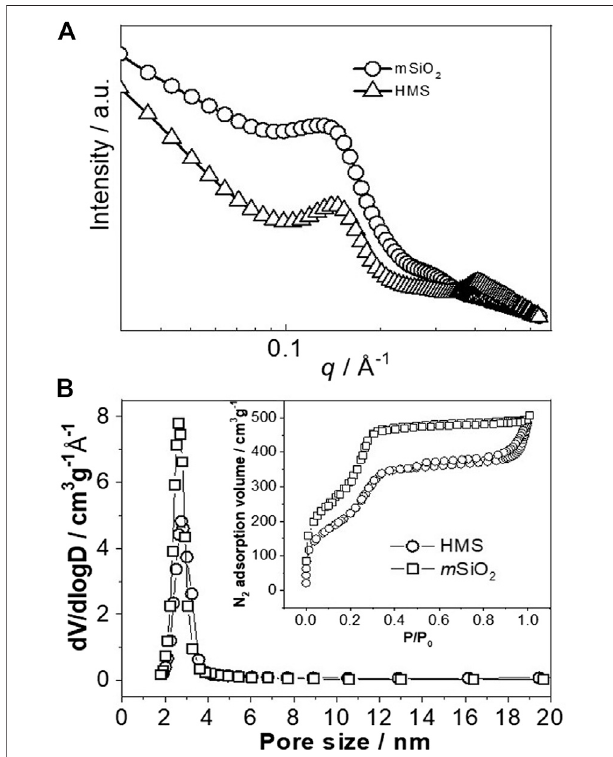
FIGURE 3 | (A) SAXS and (B) N 2 adsorption and desorption curves of m SiO 2 and